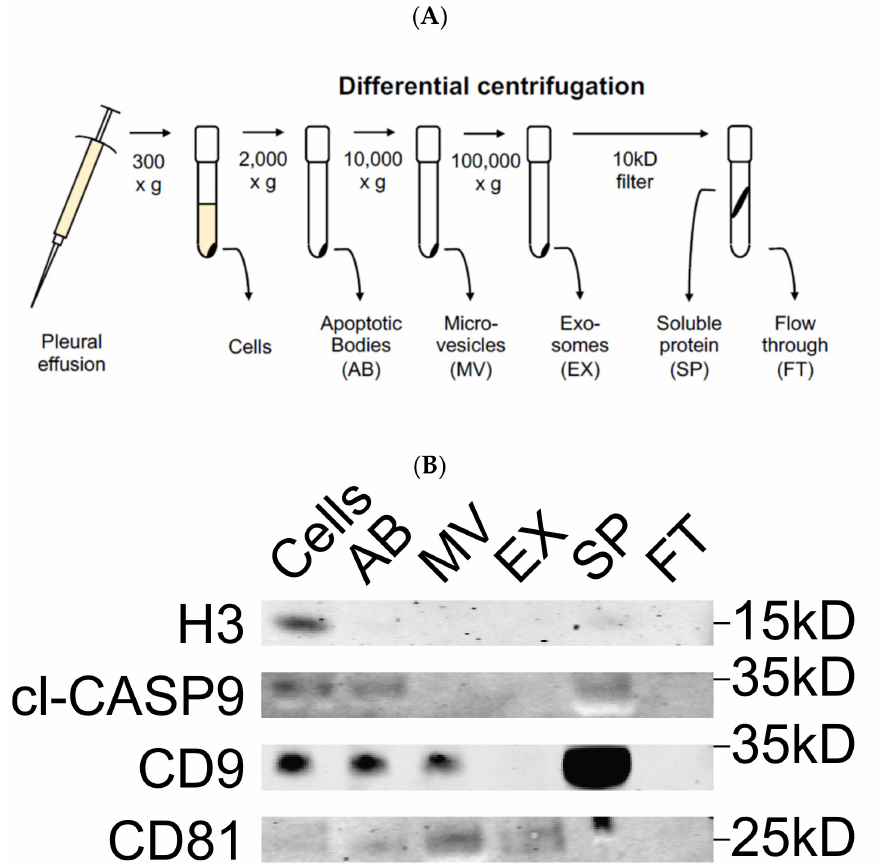
Figure 1. ( A ) Schematic of differential centrifugation protocol. ( B ) Western blot analysis of differential centrifugation fractions. The abundance of common markers (Histone H3 (H3), cleaved caspase-9 (cl-CASP9), CD9 and CD81) in different fractions was determined using Western blot. The molecular weight of each protein is shown on the